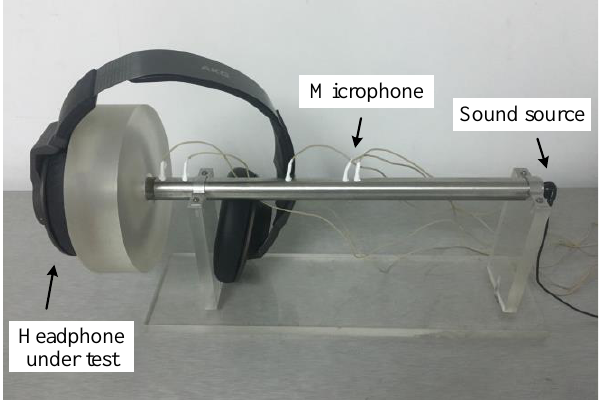
Figure 1. The microphone array method for measuring the acoustic reflectance in an impedance tube with a pinna simulator.